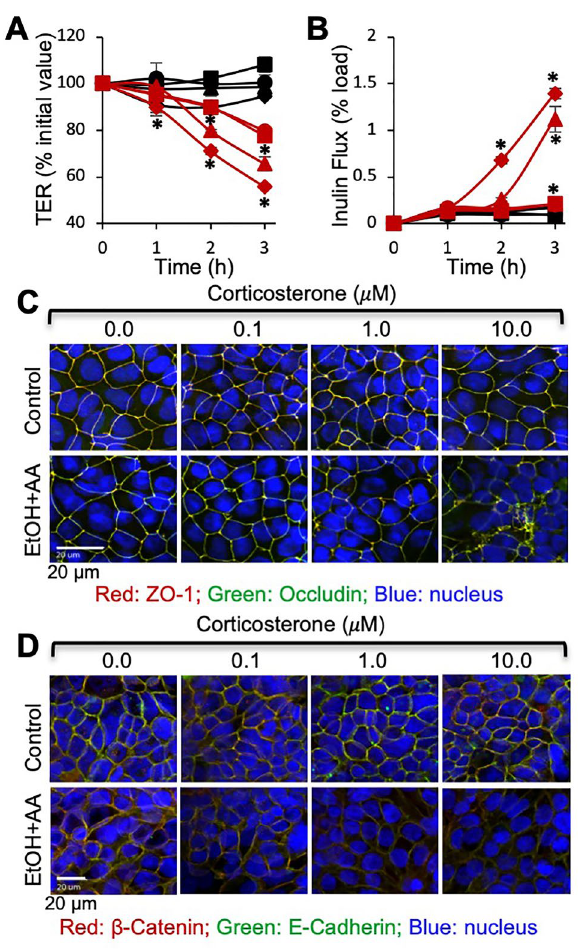
Figure 6. Corticosterone sensitizes Caco-2 cell monolayers for ethanol and acetaldehyde-induced tight junction disruption and barrier dysfunction. Caco-2 cell monolayers were pretreated with varying concentrations (black circle, red circle 0 μM, black square, red square 0.1 μM, black triangle, red triangle 1.0 μM, black diamond, red diamond 10 μM) of corticosterone (CORT) for 24 h, followed by incubation with (red circle, red square, red triangle, red diamond) or without (black circle, black square, black triangle, black diamond) ethanol (20 mM) and acetaldehyde (100 μM) (EtOH + AA). At varying times, TER ( A ) and FITC-inulin permeability ( B ) were measured. At 3 h of incubation, cell monolayers were fixed and co-stained for occludin and ZO-1 ( C ) or E-cadherin and β-catenin ( D ). Values in graphs are mean ± SEM (n = 6). Asterisks indicate the values that are significantly (P < 0.05) different from corresponding values for groups without ethanol and acetaldehyde